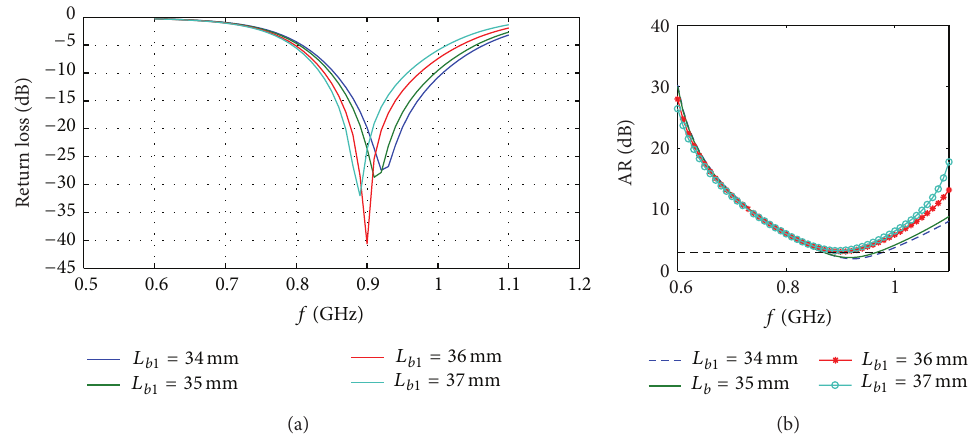
Figure 7: Comparison of S11 and AR of the antenna with different 𝐿 𝑏2 . (a) S11. (b) Axial ratio.